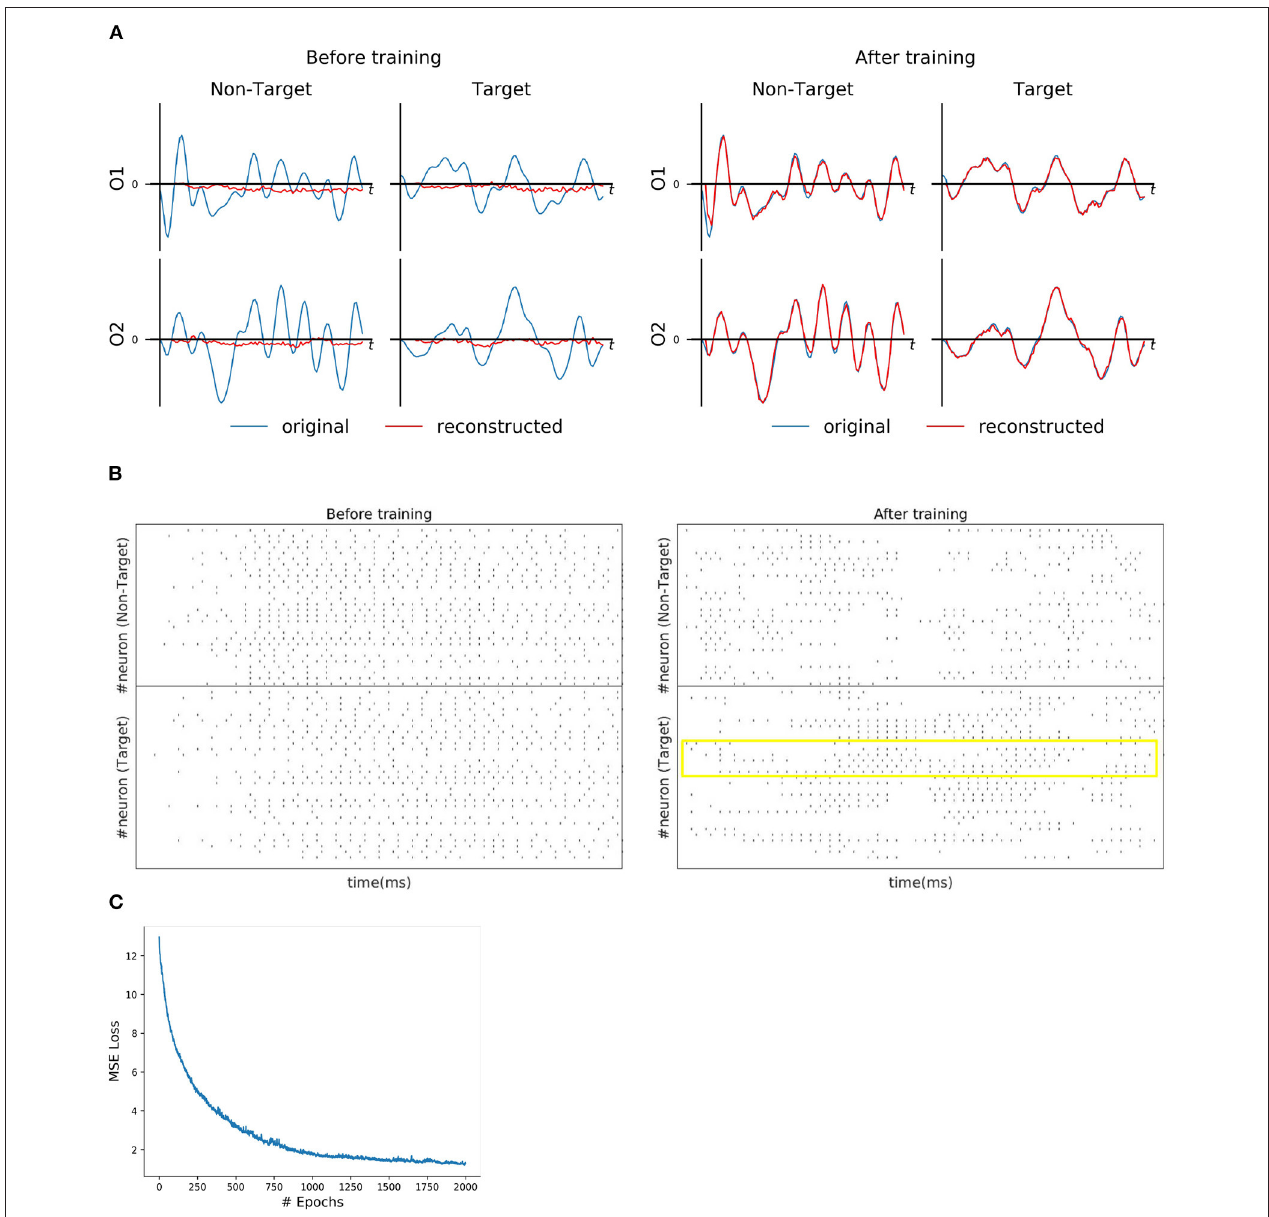
FIGURE 2 | P300 signal reconstruction outcomes. (A) Illustration of original (blue line) and reconstructed (red line) for O1 and O2 EEG signals for both Target and Non-Target classes before and after training. (B) Spike trains of RSNN activity before and after the training process from 30 randomly selected neurons. The yellow box indicates the effectiveness of the training process in reorganizing the spike trains across layers. (C) The convergence of MSE loss value across epochs during the training